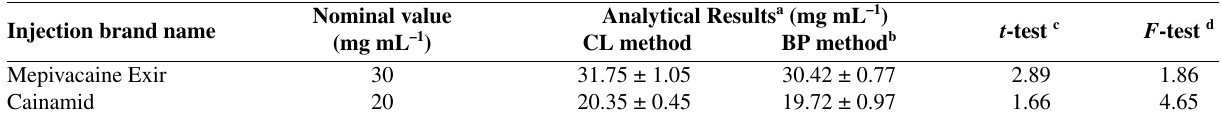
Table 3. Results of injection analysis by proposed method and their statistical comparison with reference method Injection brand name